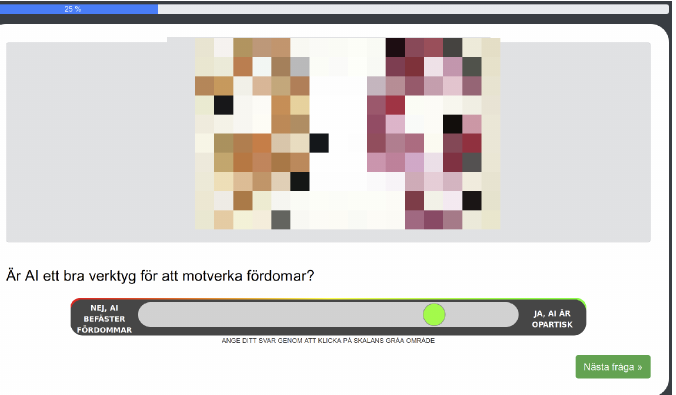
Figure 5. Screenshot of one of the questions used in the distraction task of Experiment